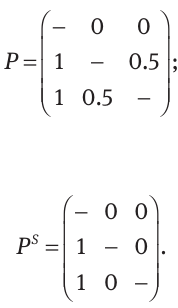
Table 7: Decision Matrix H .